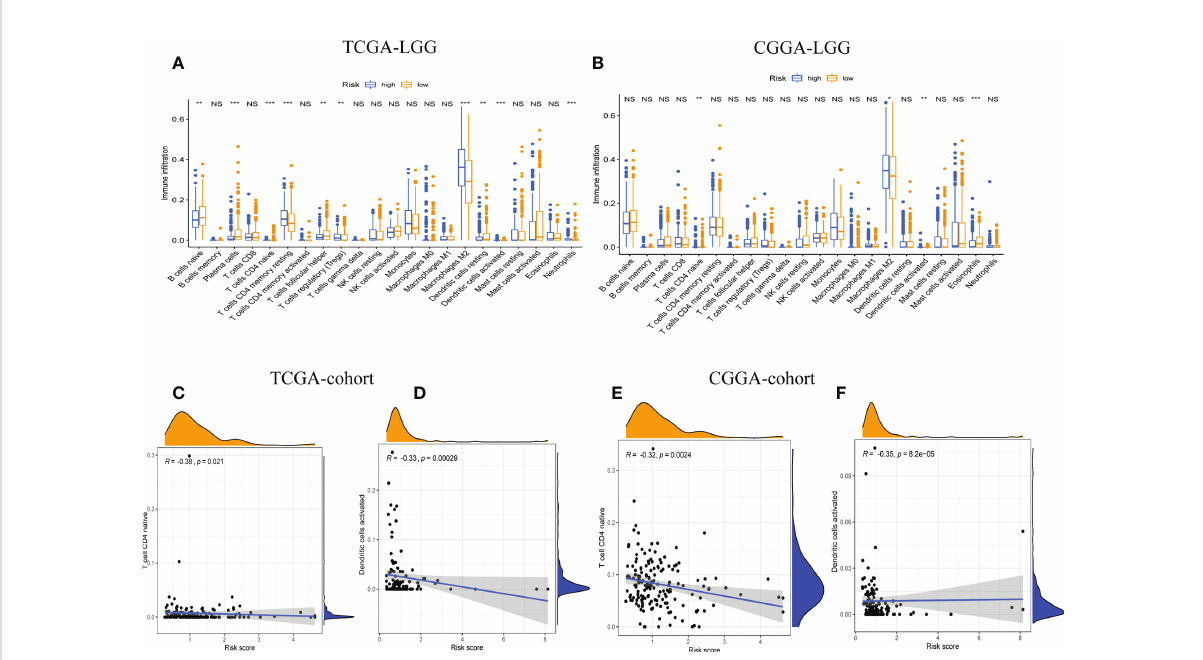
FIGURE 5 The correlation between tumor-in fi ltrating immune cells (TIICs) and GSRS. Difference analysis of 22 kinds of abundance of TIICs, immune score, and stromal score in low- and high-risk groups in training (A) and validation sets (B) . Spearman ’ s correlation analysis between risk score and M0 macrophages and CD4 memory resting T cells in TCGA (C, D) and CGGA cohorts (E, F) ; each dot plot represents a subject, and the correlation is fi tted into a straight blue line. R, rho; NS, Non Signi fi cance, ***p < 0.001, **p < 0.01, *p <